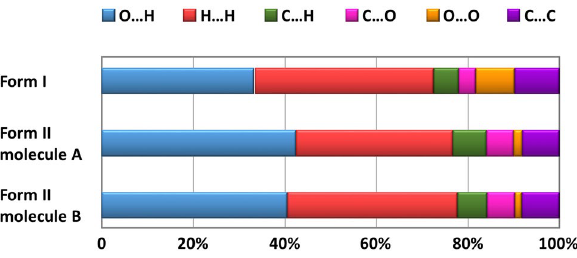
Fig. 8 The percentage contributions to the Hirshfeld surface of man- giferin form I and form II